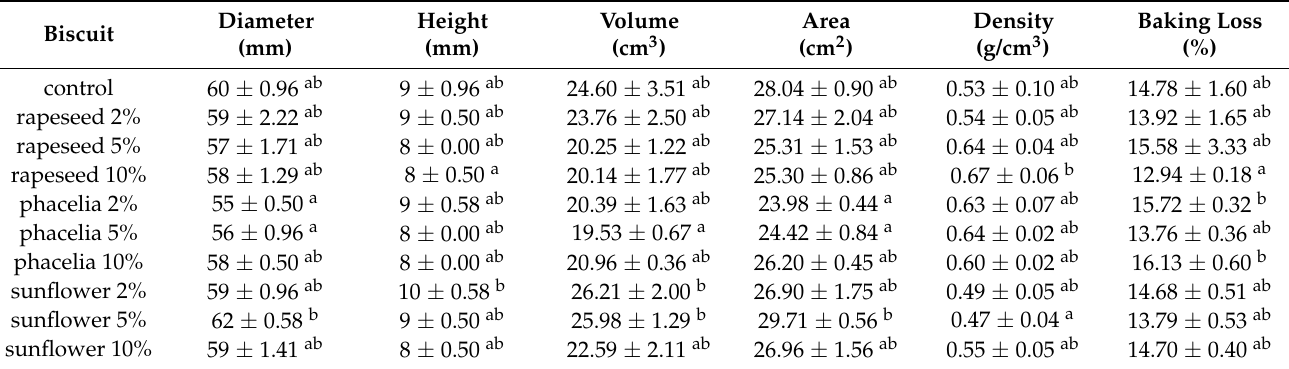
Table 6. Geometric properties and baking loss of biscuits.